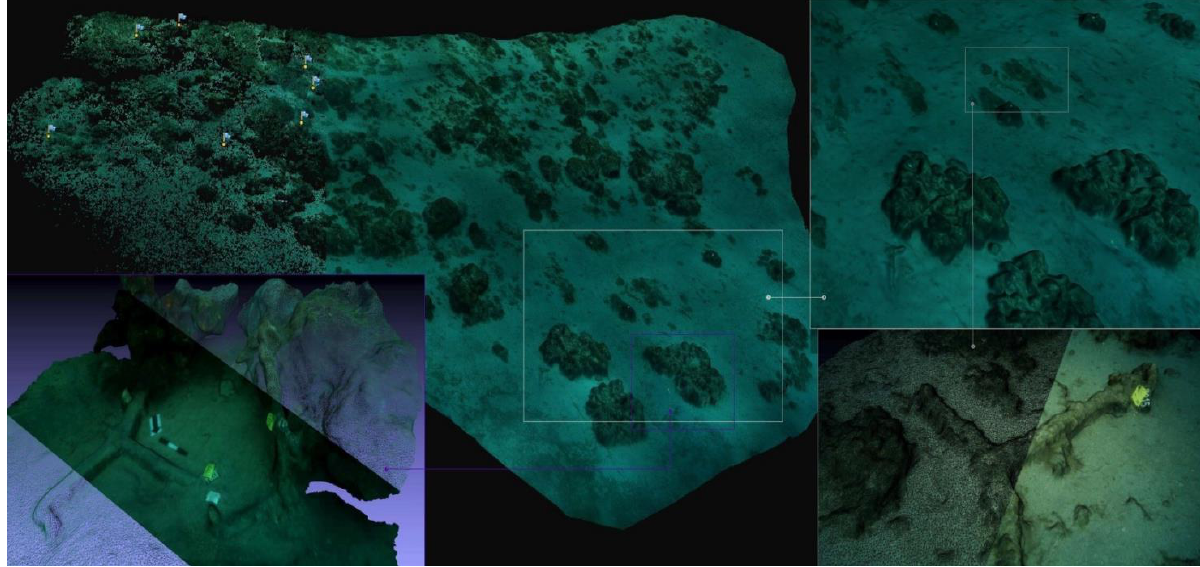
Figure 11: 3D reconstruction of Glaros underwater archaeological site (©IENAE 2015)